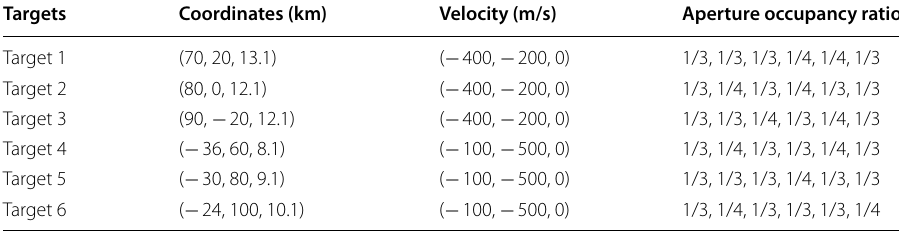
Table 2 Characteristics of the targets in scenario 2